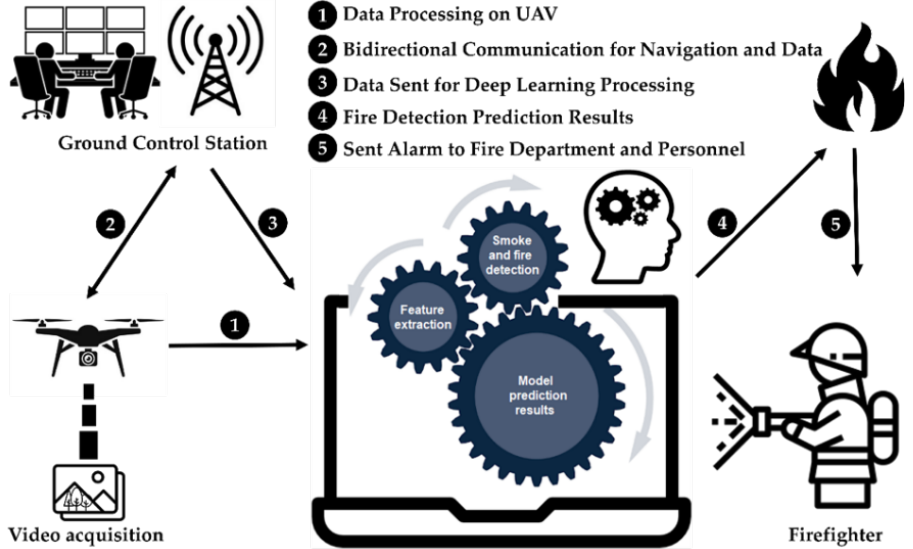
Figure 1. Overall framework of the UAV-based wildfire smoke detection system.